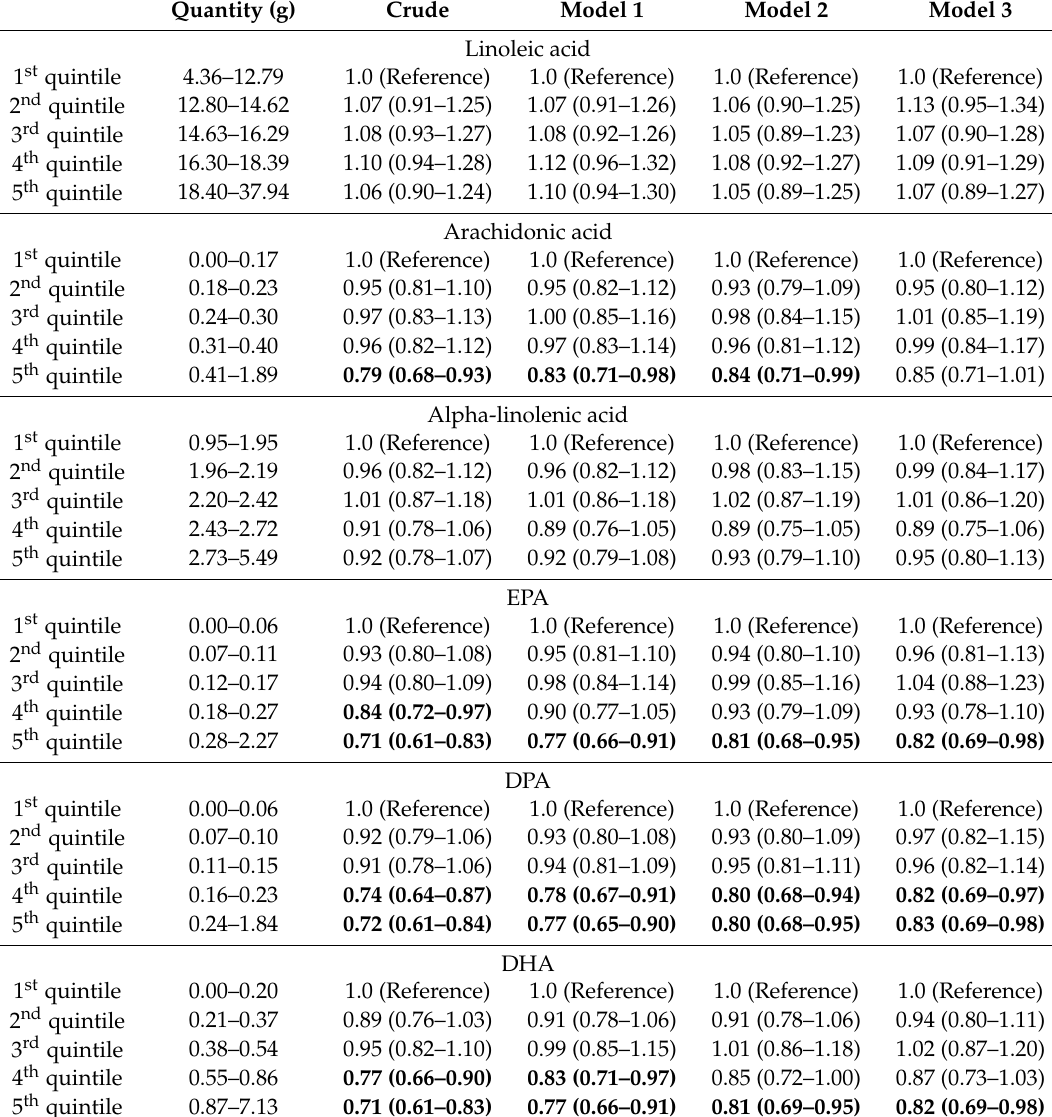
Table 3. Logistic regression, showing the odds ratio (95% confidence interval) of the association between anxiety disorder and linoleic acid, arachidonic acid, alpha-linolenic acid, EPA, DPA, DHA, PUFA, n -3, n -6 consumption, and n -6/ n -3 ratio (ELSA-Brasil,